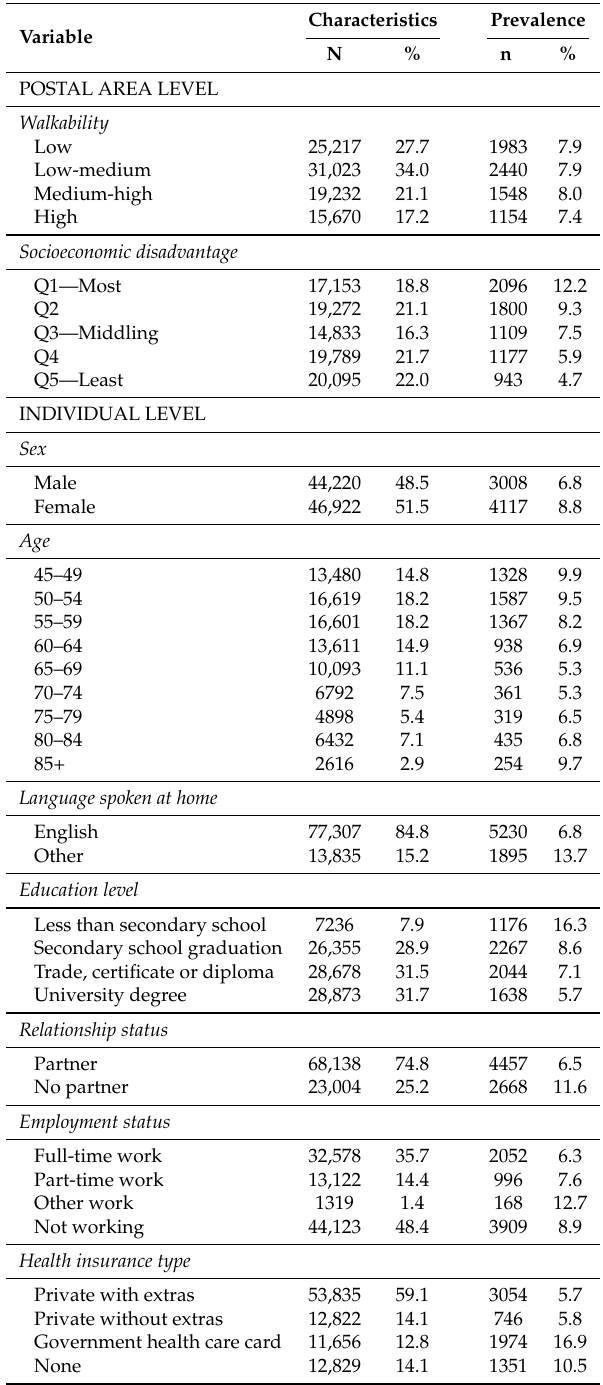
Table 1. Sample characteristics and prevalence estimates for high psychosocial